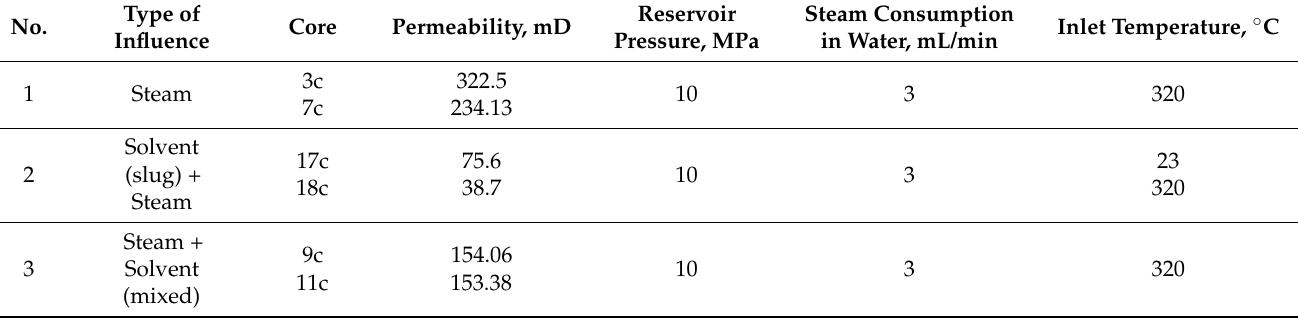
Table 11. Conditions for conducting experiments with steam only and steam with solvent.